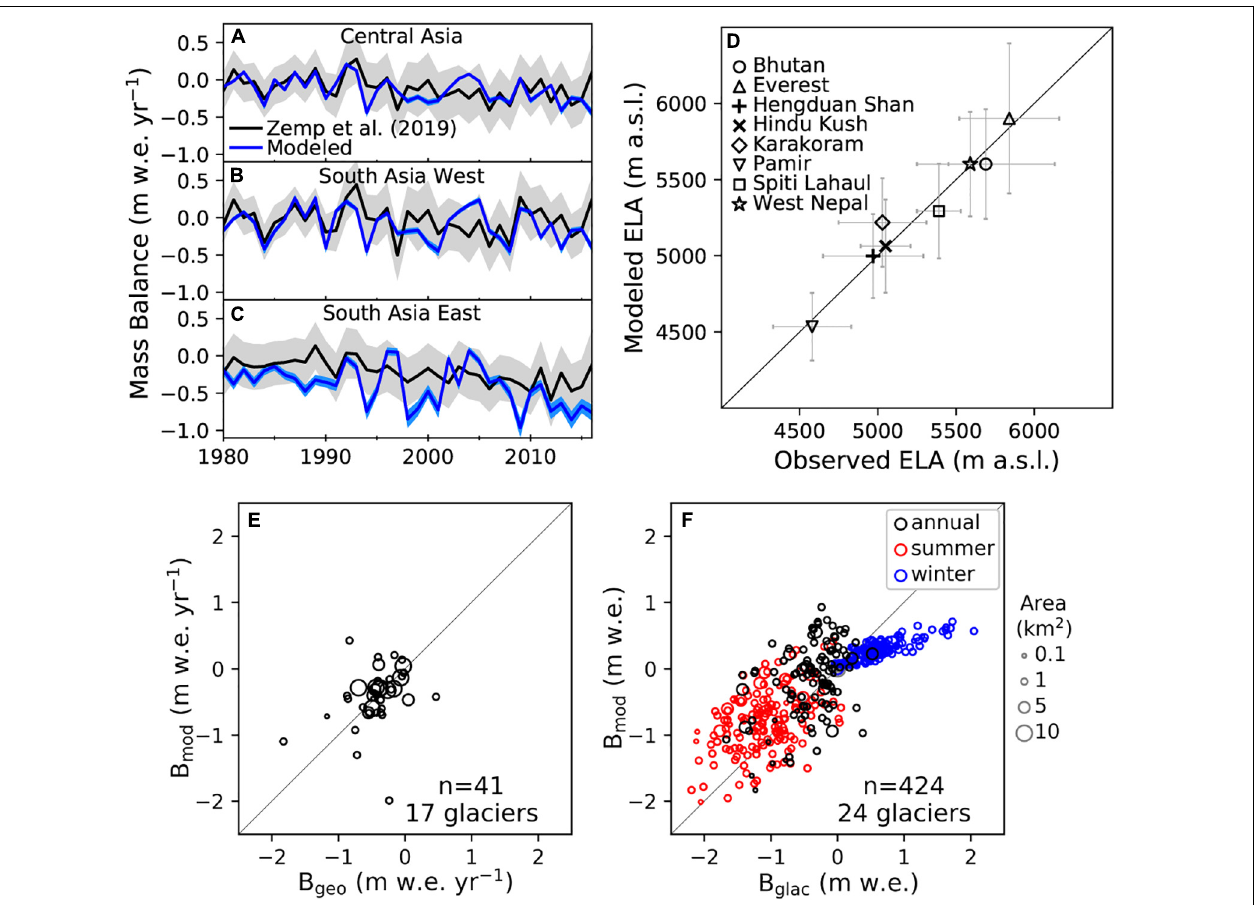
FIGURE 2 | Validation of model performance via comparison of (A–C) RGI regional annual specific mass balances (m w.e. yr - 1 ) from 1980 to 2016 with Zemp et al. (2019), (D) equilibrium line altitudes (ELA, m a.s.l.) with Gardelle et al. (2013), and mass balances from (E) geodetic (B geo , m w.e. yr - 1 ) and (F) annual, winter, and summer glaciological balances (B glac , m w.e.) (WGMS, 2018). Uncertainty reported by the observations and for the model (standard deviation) are shown for (A–D)